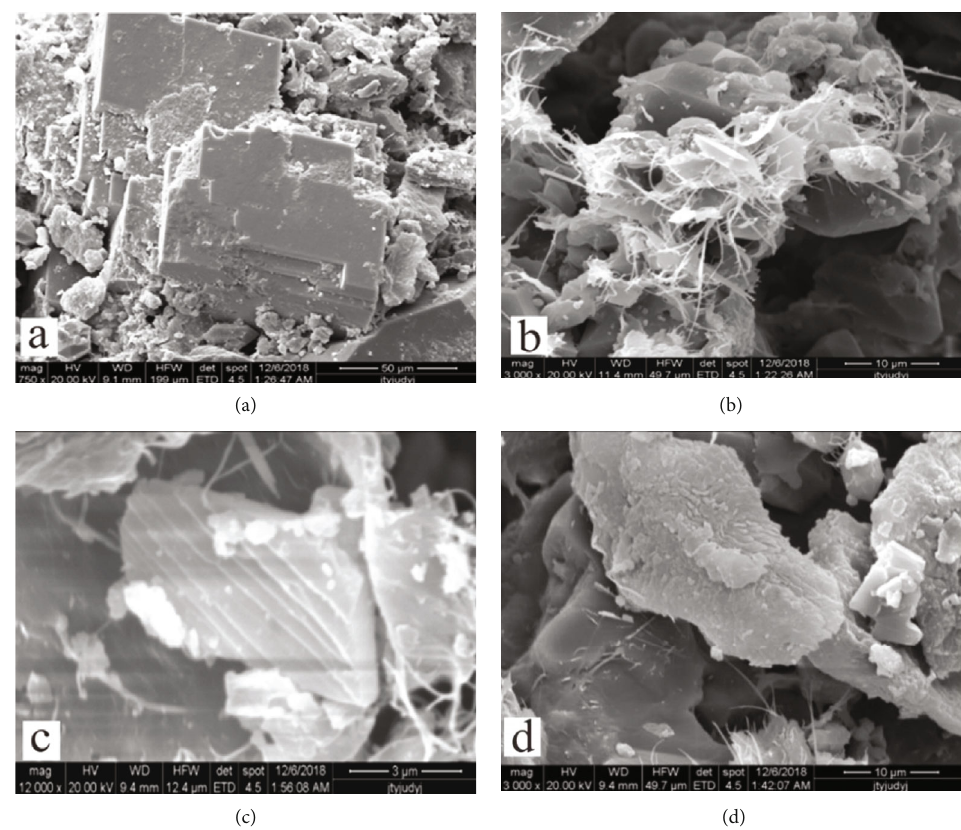
Figure 7: Characteristics under SEM